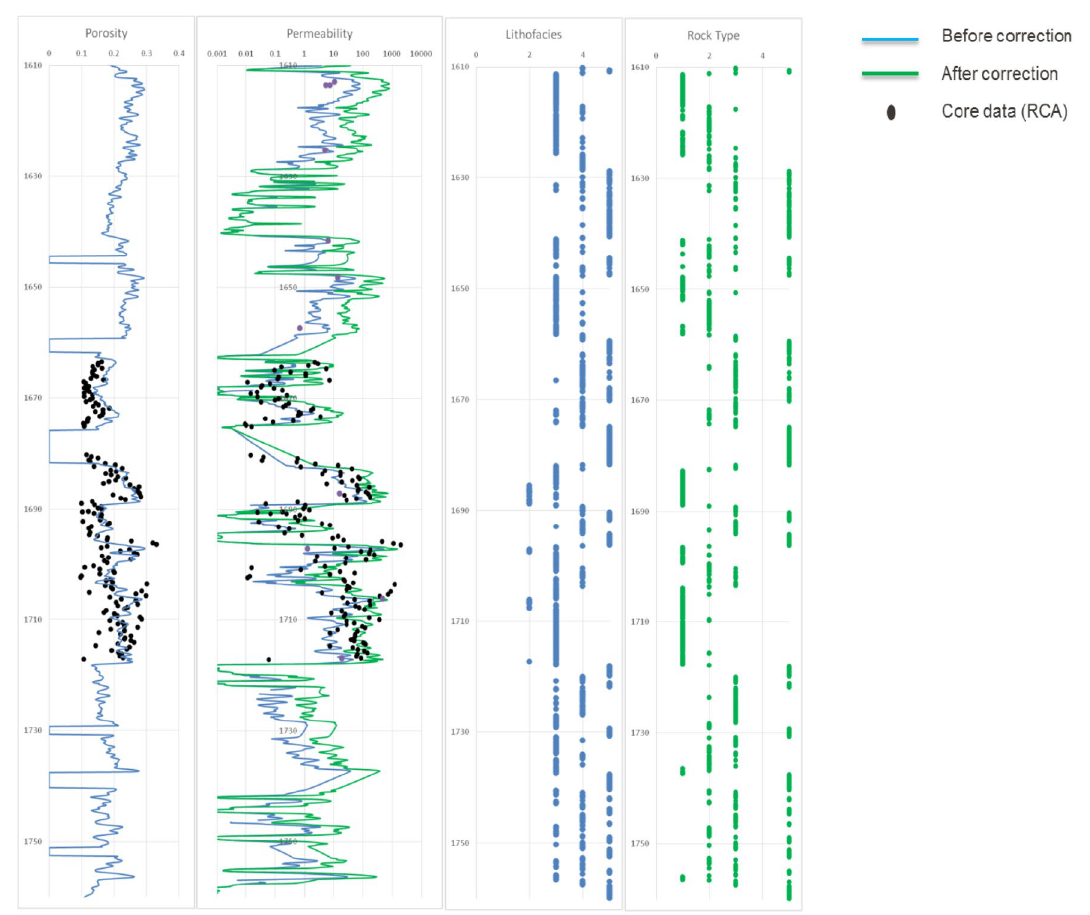
Fig. 10 Updating permeability logs and comparing facies logs to Flow Zone Indicator (FZI)